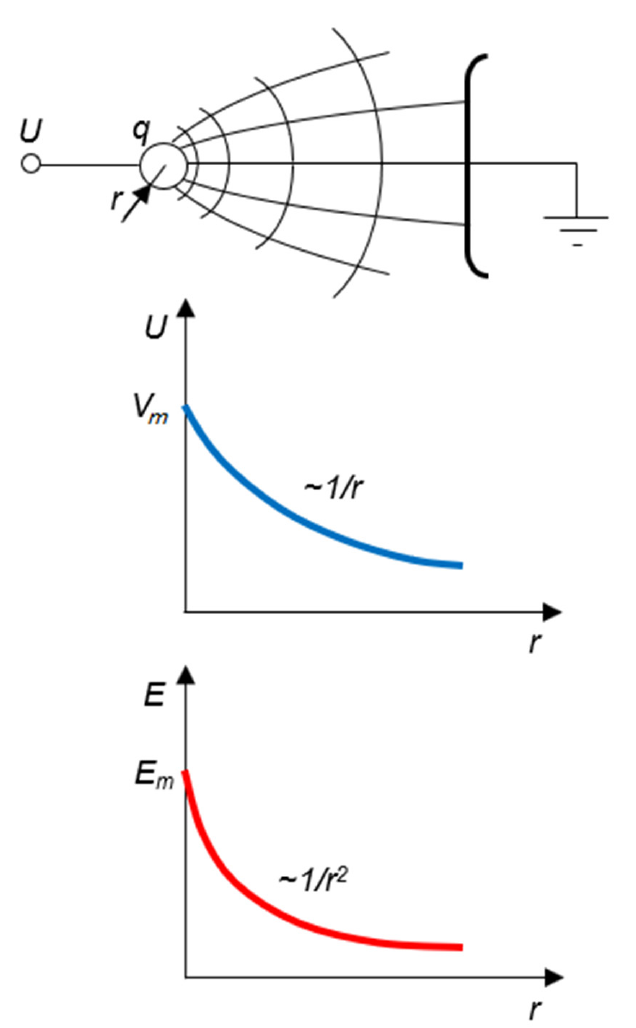
Figure 4. Distribution of potential and electric field intensity in a non-homogeneous sphere–plate